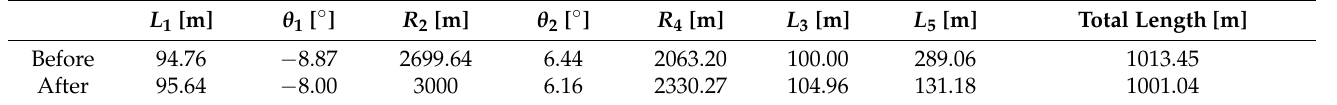
Table 6. The trajectory design parameters before and after optimization.